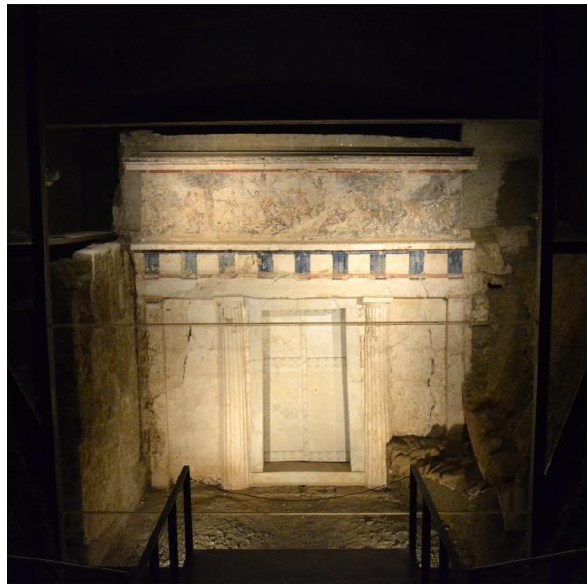
Figure 4. View of the Tomb of Persephors. Photos by the